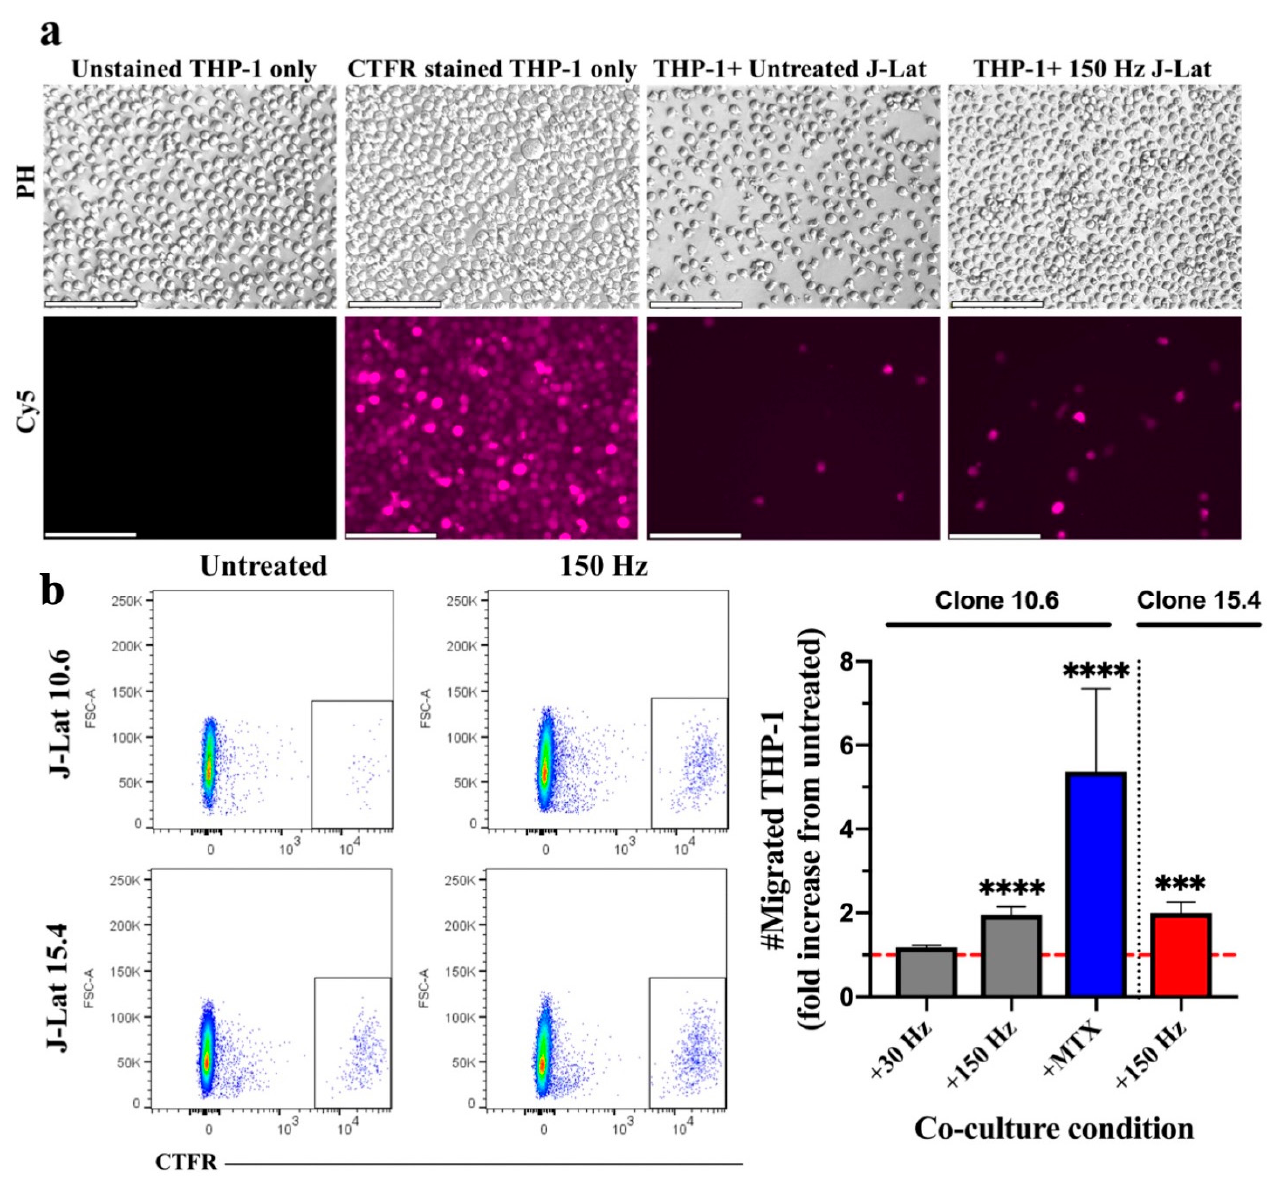
Figure 1. THP-1 monocyte migration is stimulated in response to NTP exposure of J-Lat cells. ( a ) Epifluorescence microscopy images of the basolateral chamber of the transwell system (20x magnification, scale bar is 100 µ m), showing CTFR-labeled THP-1 monocytes that migrated across the transwell insert into the basolateral chamber containing J-Lat cells (clone 10.6). Unstained and CTFR-stained THP-1 cells only were cultured in the basolateral chamber as negative and positive controls, respectively, for detection of labeled THP-1 cells. Abbreviations: CTFR, Cell-Trace Far Red; PH, phase contrast; Cy5, Cyanine 5 (used CTFR fluorescence). ( b ) The number of migrated THP-1 monocytes (CTFR-labeled) 24 h later increased in the presence of J-Lat cell clones 10.6 or 15.4 exposed to NTP at 150 Hz, as shown by representative scatter plots and the graph (gray, clone 10.6 exposed to NTP; blue, clone 10.6 exposed to MTX; red, clone 15.4 exposed to NTP). The dotted red line in the graph indicates no change with respect to cells not exposed to NTP (untreated). Mitoxantrone (MTX) was used as positive control for migration. Statistical significance was calculated using the Kruskal–Wallis test, according to the NTP-naïve (untreated) J-Lat co-culture control (*** p < 0.001, **** p <